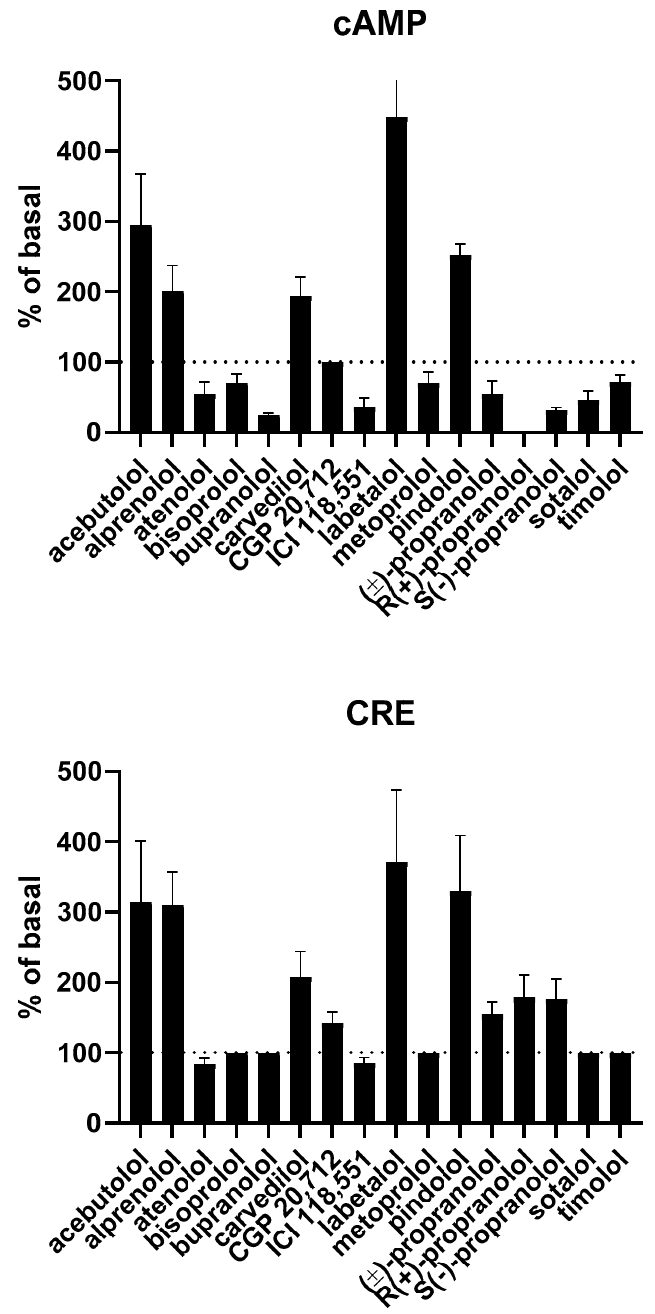
Figure 4. E ffi cacy of ligands for cAMP accumulation and the activation of a cAMP response element (CRE) reporter gene in cells stably transfected with human β 2 -AR. The figure was generated based upon data from [15]. Each bar represents means ± SD of E max as the % of basal derived from 3–38 concentration-response experiments. Note that the e ffi cacy of the most e ffi cacious ligand, labetalol, was 8.5% and 66.9% of the maximum isoprenaline response in the cAMP and CRE assay, respectively. The stimulation of cardiac β -AR can lead to elevations of intracellular Ca 2+ . A study of most cardiomyocytes found that concentrations of ICI 118,551 can reduce the elevated Ca 2+ concentrations induced by the PI-3 kinase inhibitor LY 294002 or the phosphodiesterase type 4 inhibitor milrinone [90]. Similarly, the activation of L-type Ca 2+ channels by a peptide corresponding to the second loop